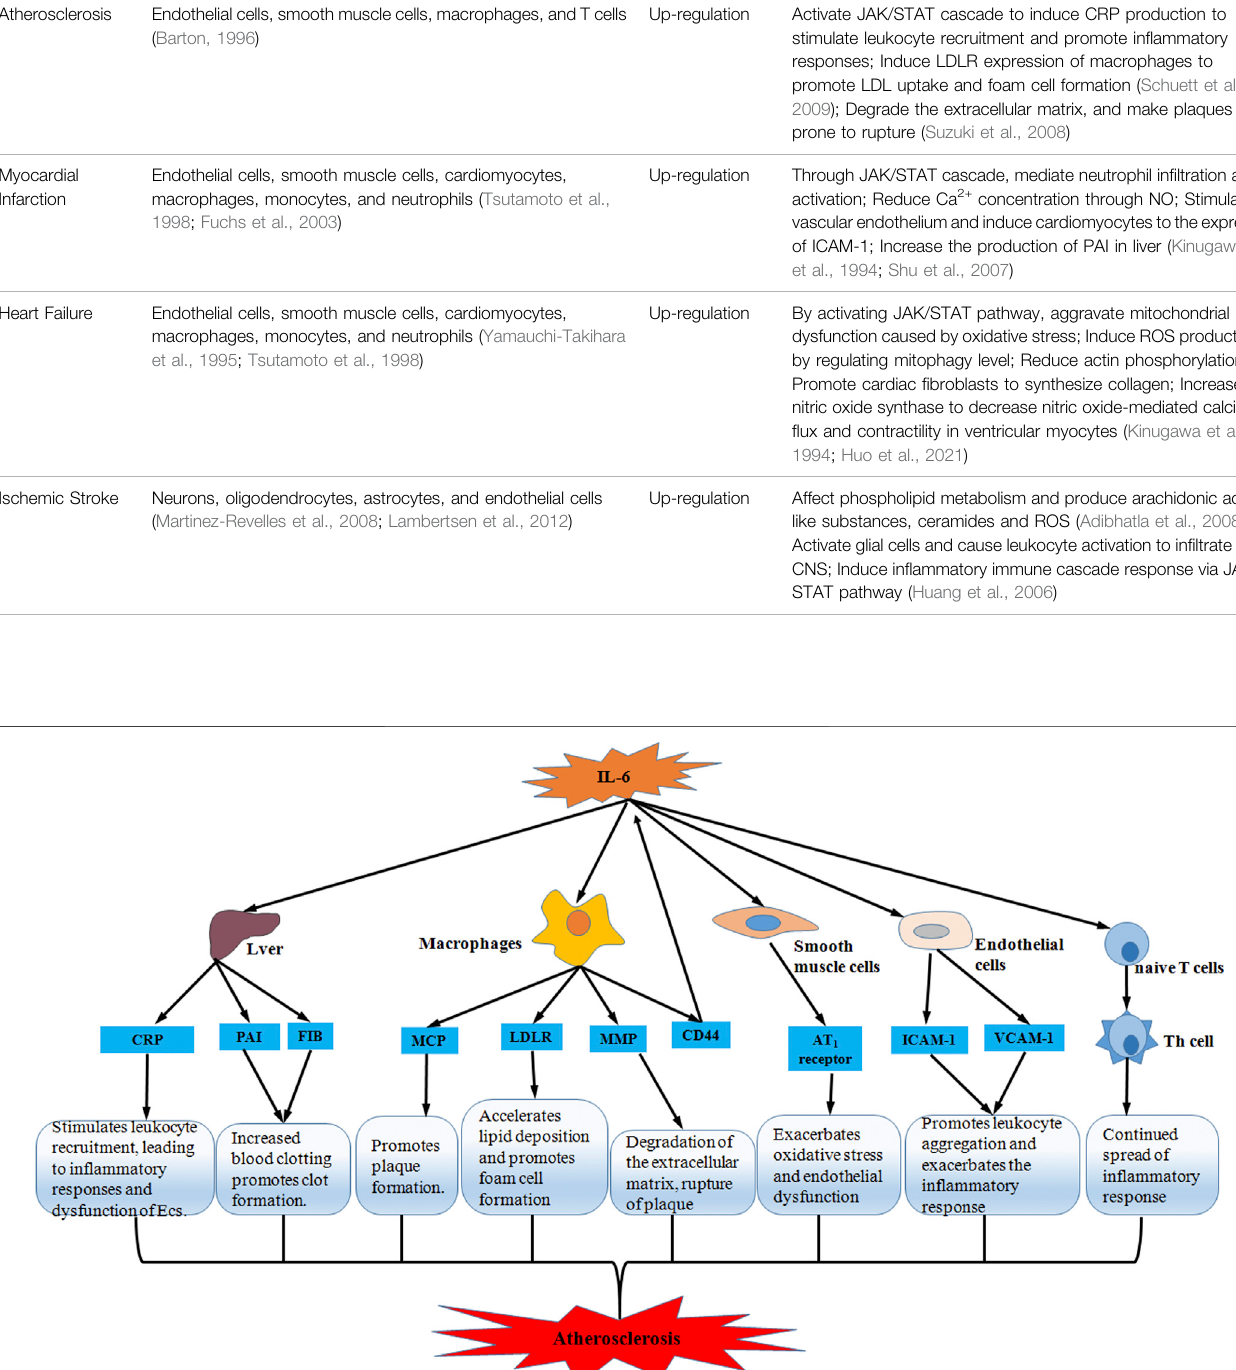
Frontiers in Pharmacology |